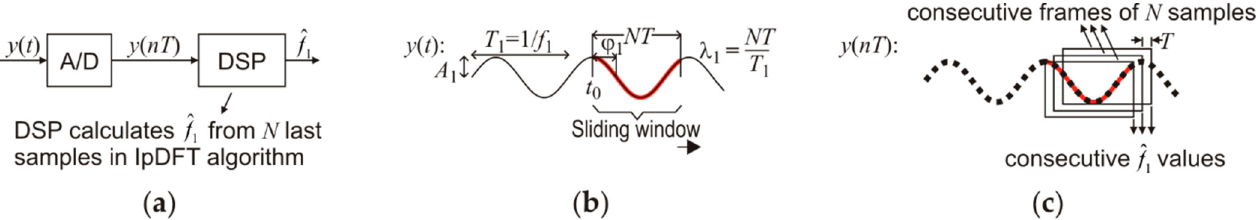
Figure 13. Determining the frequency estimate f 1 by zero-crossing (ZC) method and the maximum estimation error f with low-pass prefiltering: ( a ) three prefiltering options (ZC 1 , ZC 2 and ZC 3 ); ( b ) estimation of f 1 in ZC method with linear interpolation.